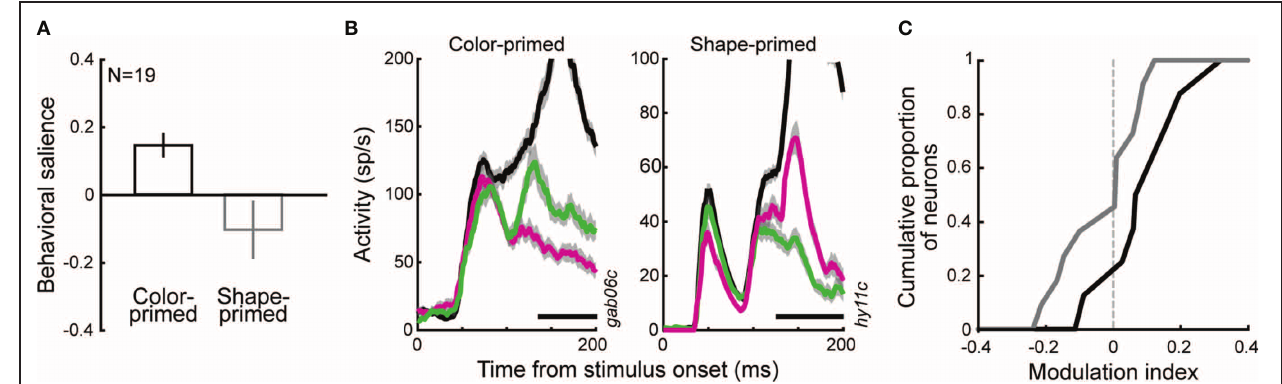
FIGURE 7 | Effects of between-session priming in balanced displays. (A) Average ( ± SE) index of behavioral salience for two monkeys (G and H) in either color- ( n = 8) or shape-primed ( n = 11) sessions. (B) Two sample neurons’ activities in balanced display trials during sessions that were either